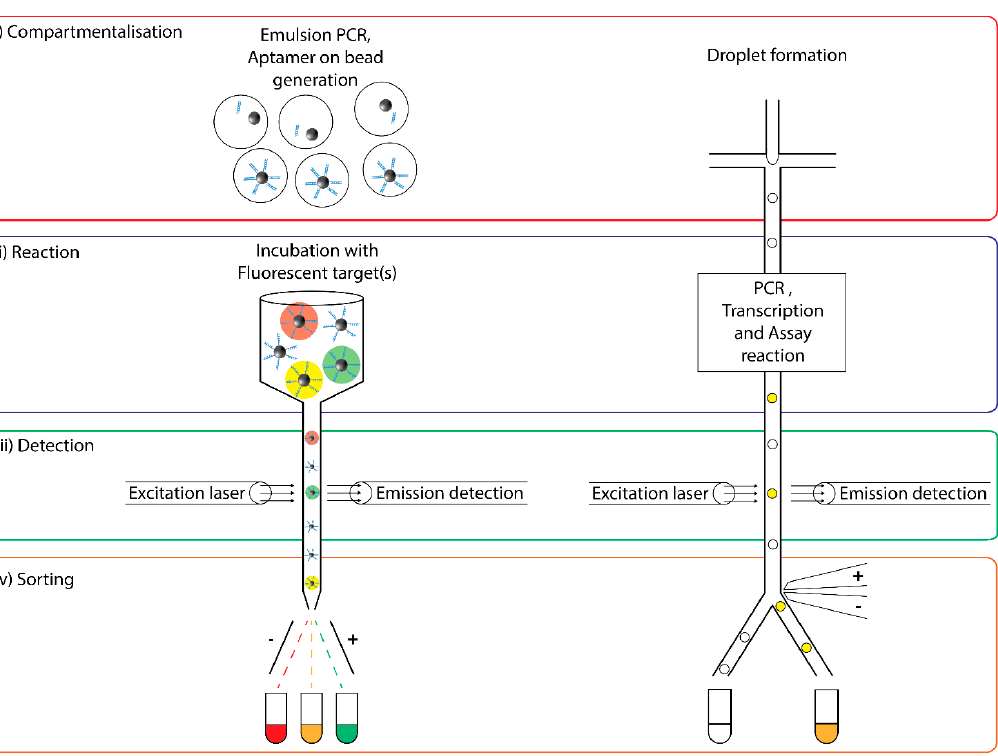
Figure 5. Comparison of ( A ) Fluorescence Activated Cell Sorting (FACS) and ( B ) Fluorescence Activated Droplet Sorting (FADS). ( A ) For FACS (Ai) ePCR, emulsion breaking and alkaline hydrolysis are used for generation of monoclonal aptamer bead library. (Aii) monoclonal beads are incubated with fluorescent target. (Aiii) Monoclonal beads are excited with a laser and their fluorescent emission intensities quantified. (Aiv) Beads are sorted by an electric field based upon fluorescence emission intensities (B) for FADS (Bi) Droplets are formed using microfluidics. (Bii) ePCR and transcription results in monoclonal droplets before addition of reaction reagents. (Biii) Monoclonal beads are excited with a laser and their fluorescent emission intensities quantified. (Biv) Beads are sorted by an electric field based on fluorescence emission intensities.